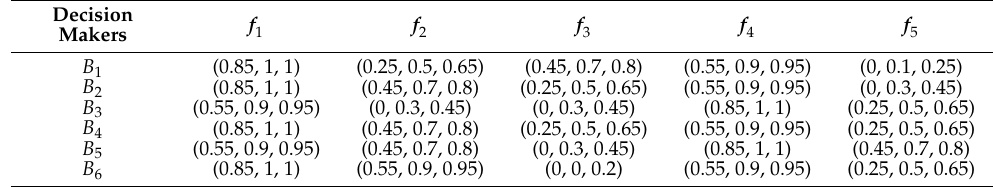
Table 8. Importance evaluations transformed from semantic variables to triangular fuzzy numbers.